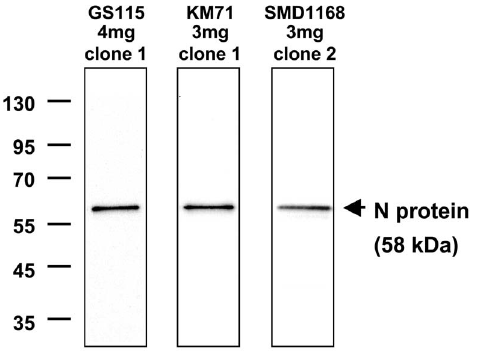
Figure 1. Expression of N protein in GS115, KM71 and SMD1168 P.pastoris strains. Concentrations of Geneticin in selection plates for the specific clones, and clone numbers, are indicated. Yeast lysates were diluted 1/600 before loading on western